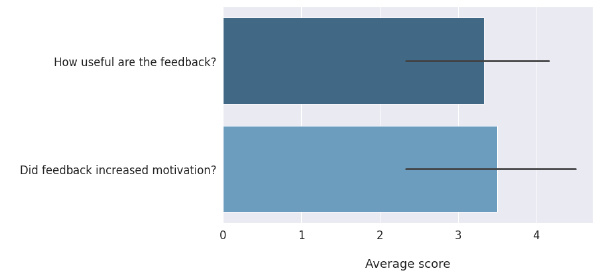
Figure 13. Average scores given to two questions regarding receiving automatic feedback. minimum score 1, and maximum score 5 and 0.34 for the correlation between frequency of use and role Figure 12. Adding bird species name in BioSenCS application: of feedback in increasing User does not know the species name (a), participant ask for suggestions to add the species name (b), and participant knows the species name and type the name and an auto-complete of bird names is offered (c)